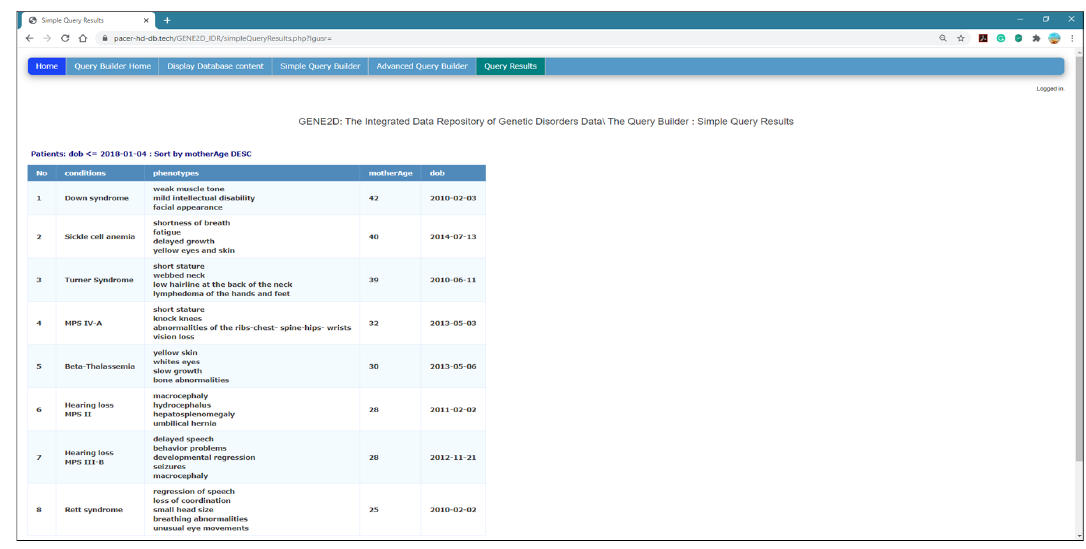
Figure 8. The Simple Query Results page.